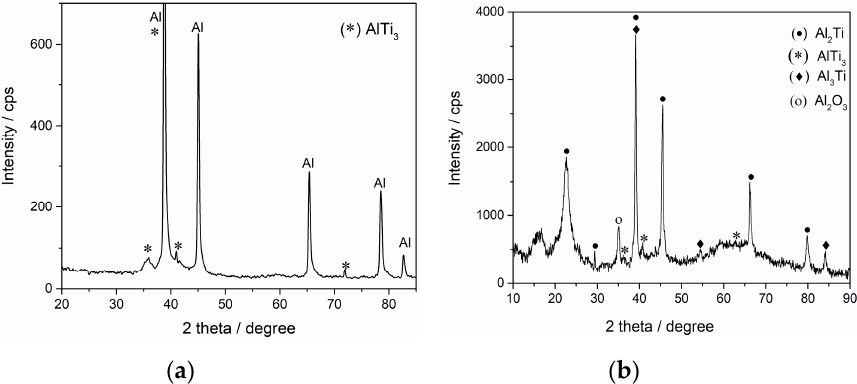
Figure 9. XRD patterns of the deposits obtained potentiostatically on the GC electrode on different conditions: ( a ) at − 0.085 V and 200 °C for two hours; ( b ) at − 0.020 V and 300 °C for two hours.